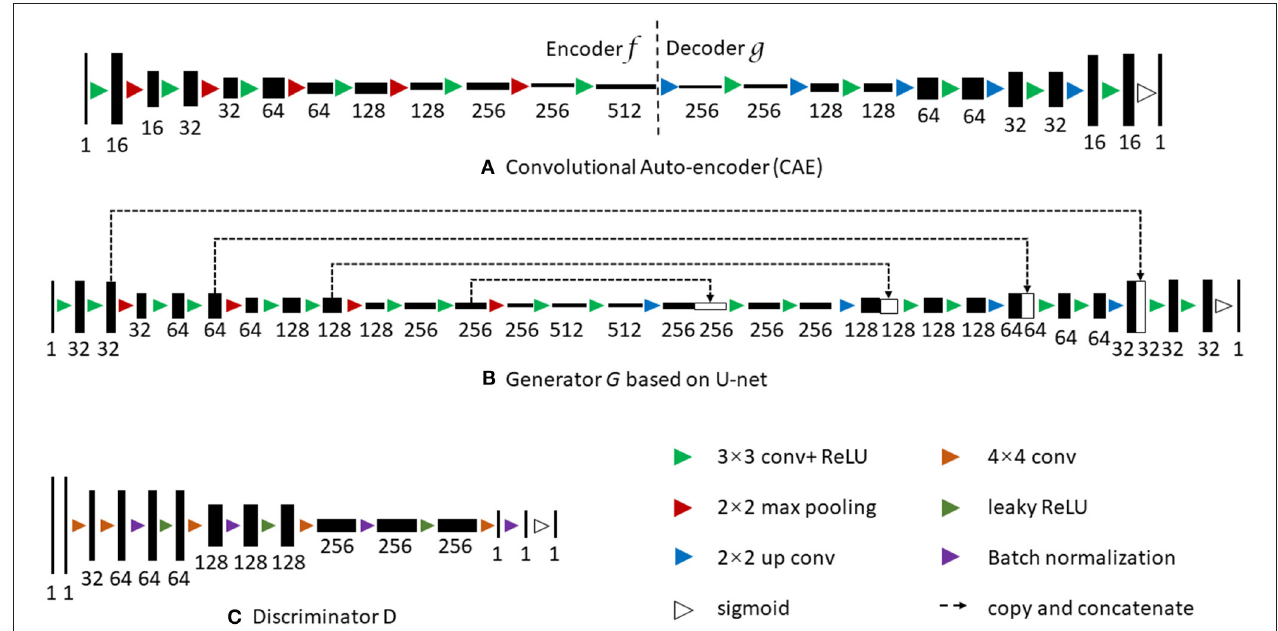
FIGURE 4 | FSPET architecture: (A) convolutional auto-encoder (CAE), (B) Generator (G), and (C) Discriminator (D).